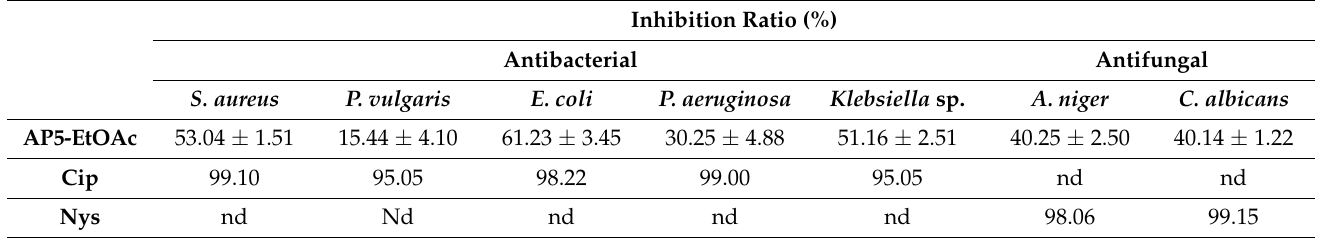
Table 1. In vitro antimicrobial (antibacterial and antifungal) activity of Aspergillus sp. AP5 Crude extract. Inhibition Ratio (%) Antibacterial